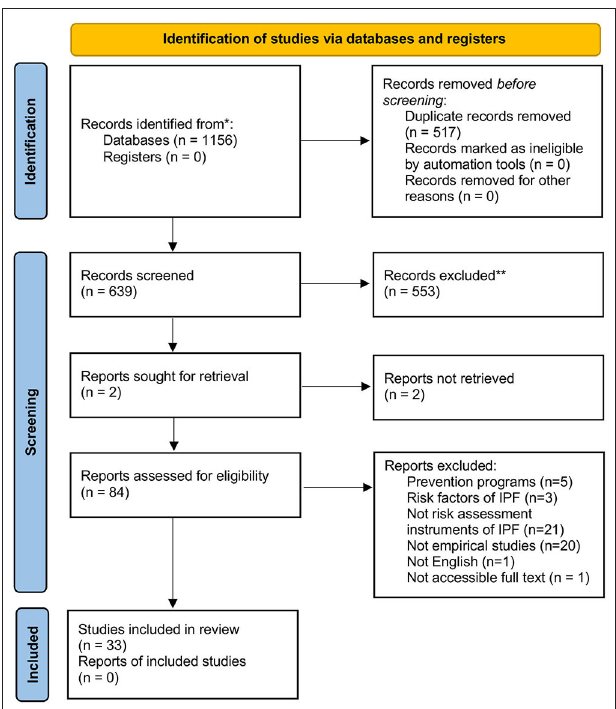
FIGURE 1 | PRISMA flow diagram of the study selection process (Page et al., 2021